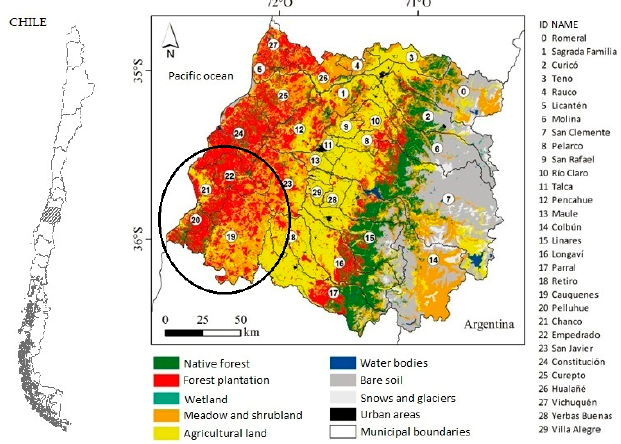
Figure 1. Study area location (within the black circle) and Maule Region land use [29].